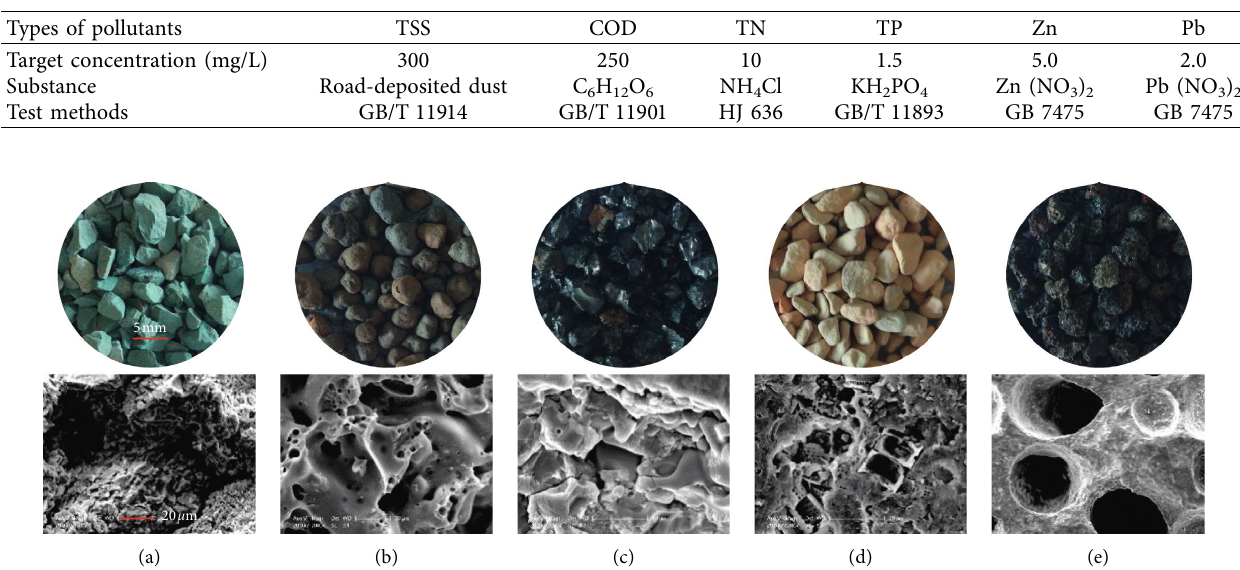
Figure 2: Illustration of research plan. Table 1: Pollutant characteristics of synthetic pavement runoff.